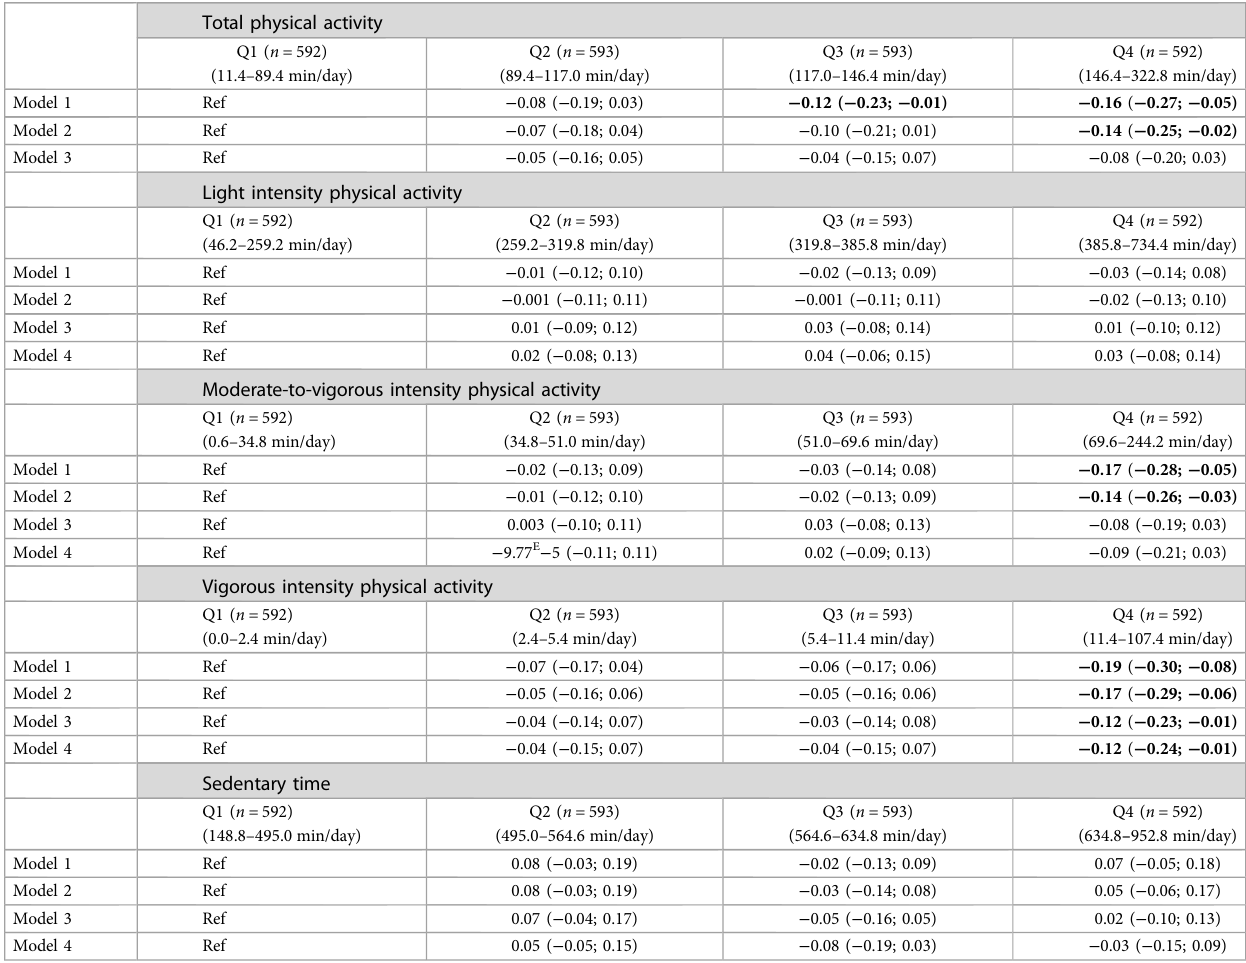
TABLE 4 Associations of physical activity and sedentary behavior with NT-proBNP (categorical) ( n